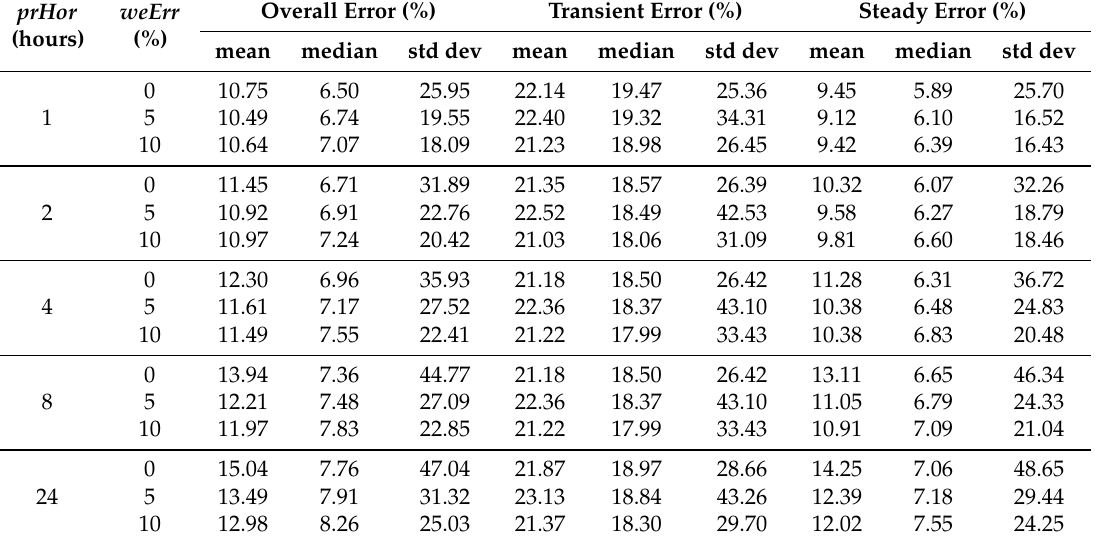
Table 5. Sensitivity analysis on weather maximum error